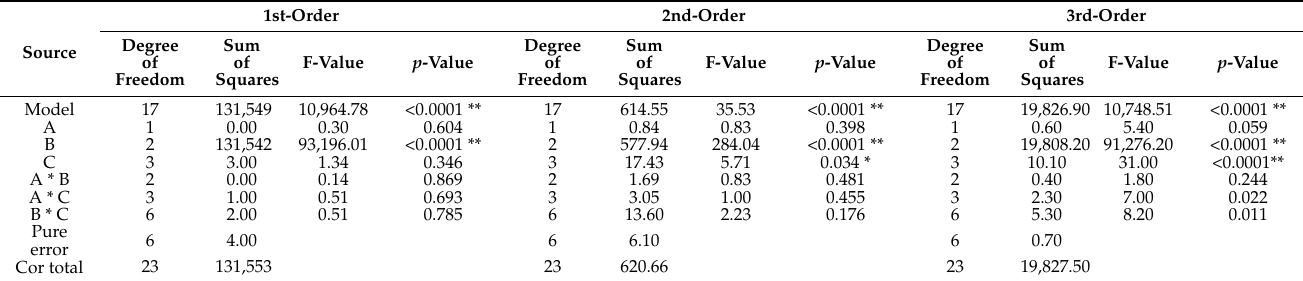
Table 4. Variance analysis of factors affecting main frequency distribution.